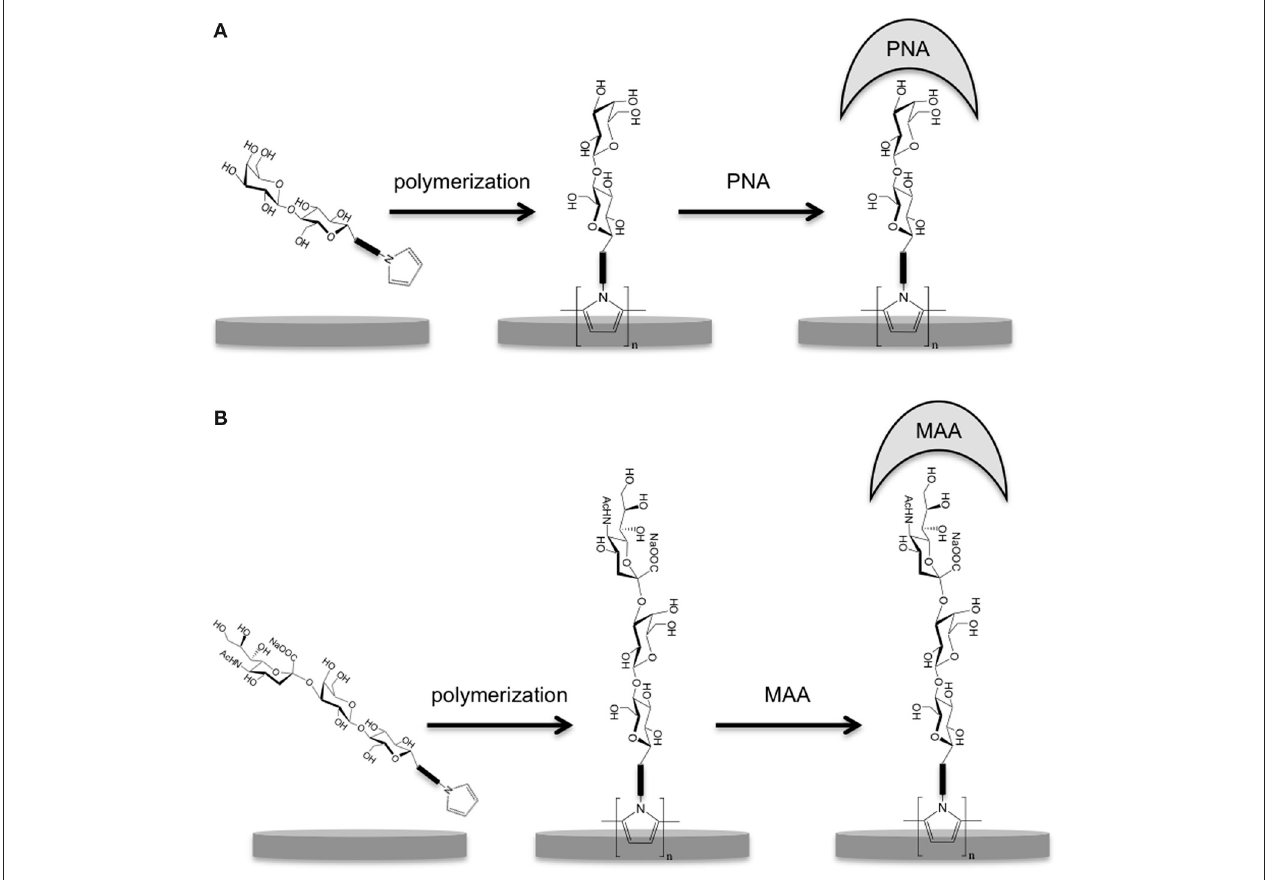
FIGURE 1 | Schematic representation of (A) poly(pyrrole-lactosyl) film formed on electrodes by electropolymerization of pyrrole-lactosyl and detection of PNA; (B) poly(pyrrole-3 (cid:2) -sialyllactosyl) film formed on electrodes by electropolymerization of pyrrole-lactosyl and detection of MAA.